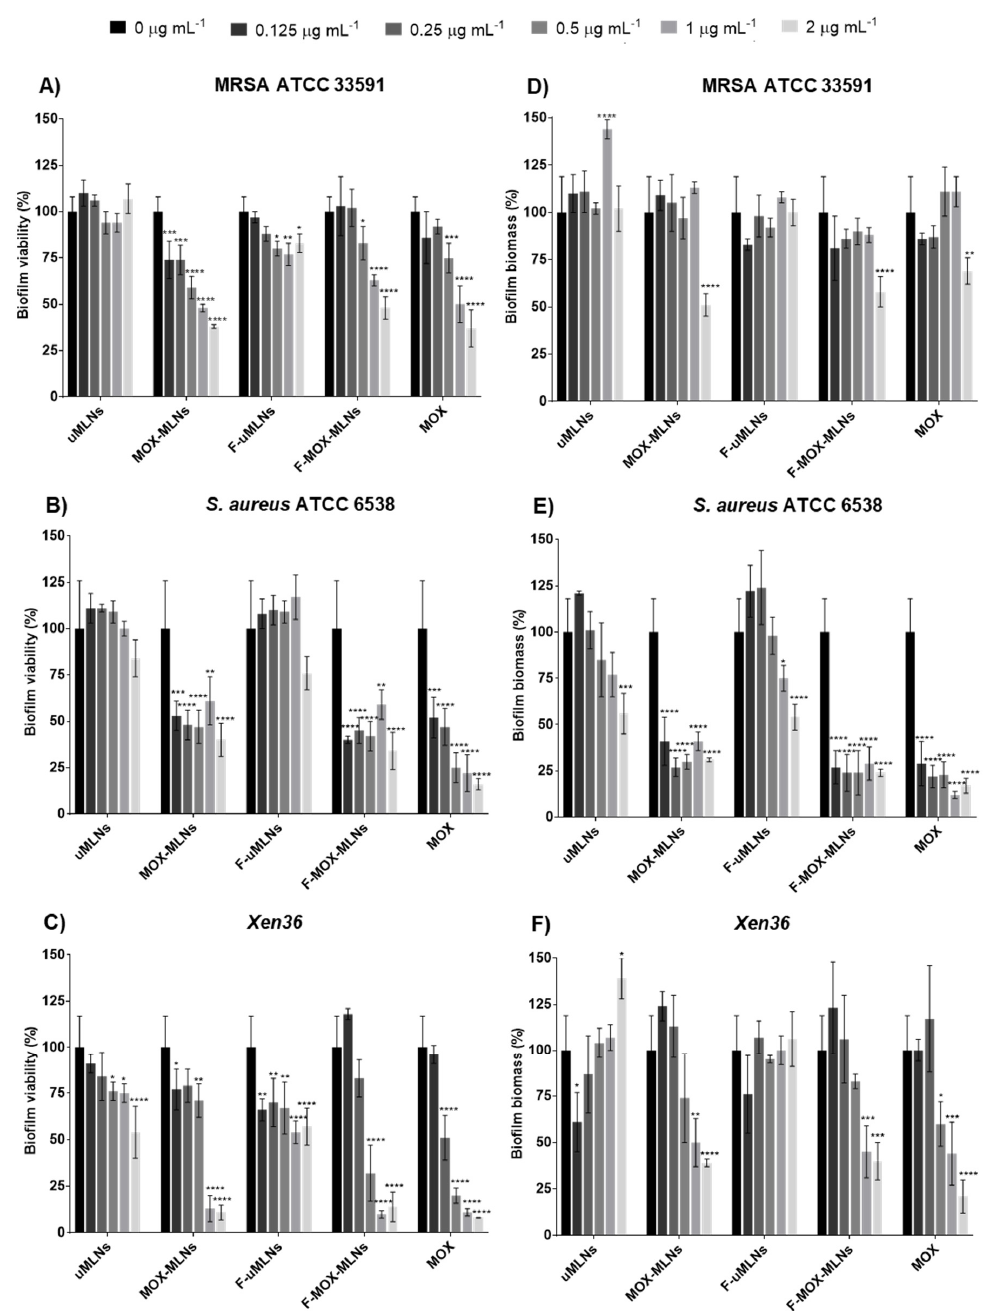
Figure 4. Quantification of ( A – C ) biofilm viability (XTT assay) and ( D – F ) biomass (crystal violet staining) after a 24 h treatment with MLNs and free MOX at the concentrations of 0, 0.125, 0.25, 0.5, 1, and 2 µg mL − 1 of MOX. Unloaded MLNs were tested at the same concentration. The biofilms of ( A , D ) MRSA ATCC 33591, ( B , E ) S. aureus ATCC 6538, and ( C , F ) the bioluminescent strain Xen36 were grown in 96-well plates for 24 h before the treatment. Untreated biofilms (0 µg mL − 1 of MOX) were used as a positive control, and TSB 0.6x supplemented with 0.2% ( w/v ) glucose was used as a negative control. The values are represented as the mean ± SD. * p < 0.05, ** p < 0.01, *** p < 0.001, **** p < 0.0001 relative to 0 µg mL − 1 . Statistical analysis: two-way ANOVA, Dunnett’s multiple comparisons test.